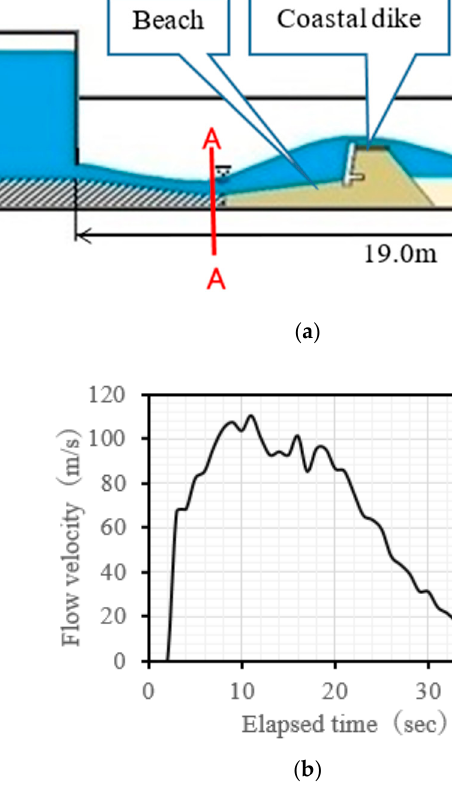
Figure 1. ( a )Illustration of experimental apparatus for arising scour in the landside of the coastal dike. ( b ) Example of flow velocity on the crown part of the dike.